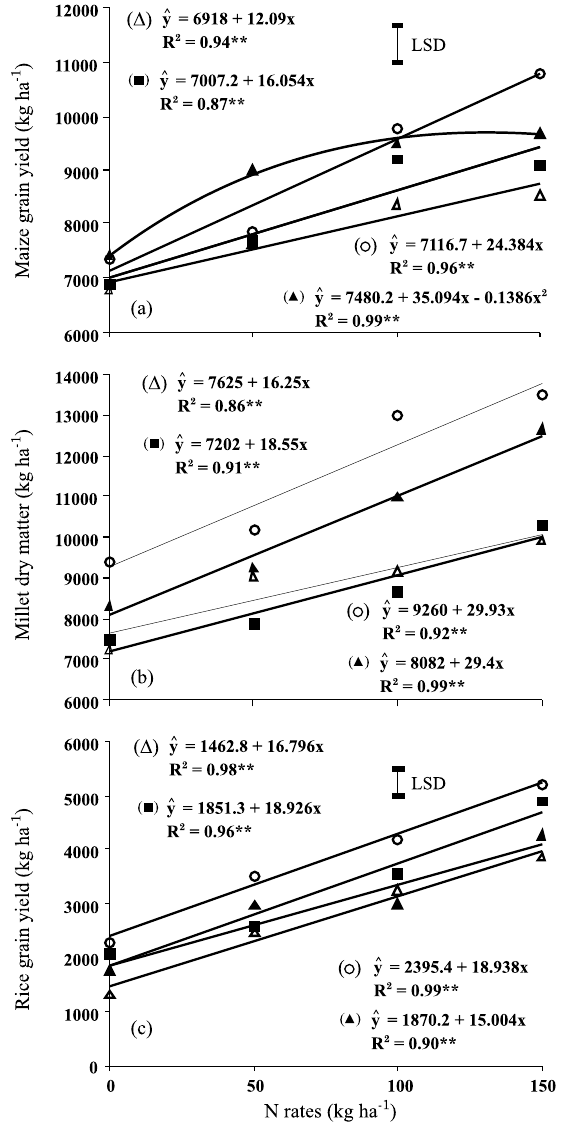
Figure 1. Maize grain yield (a), pearl millet dry matter (b) and upland rice grain yield (c) as affected by increasing N fertilization in different lime rates: 0 ( ΔΔ ΔΔ Δ ); 1500 ( ); 3000 ( o ) and 6000 kg ha -1 ( ). * and ** : significant at 5 and 1%, respectively. Vertical bars show LSD (p < 0.05) for the N x lime rates interaction, and there was no interaction for upland rice